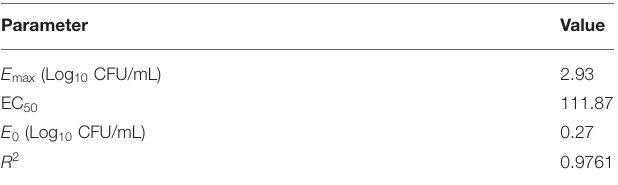
TABLE 3 | Estimation of AUC 0 − 168 /MIC (h) and increases in antibiotic-resistant bacteria.